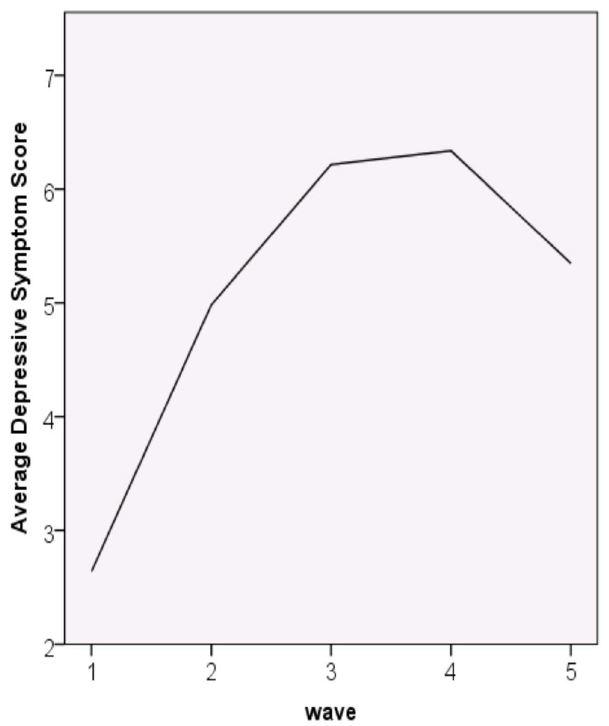
Figure 1. Average growth curve of depressive symptoms across the internship